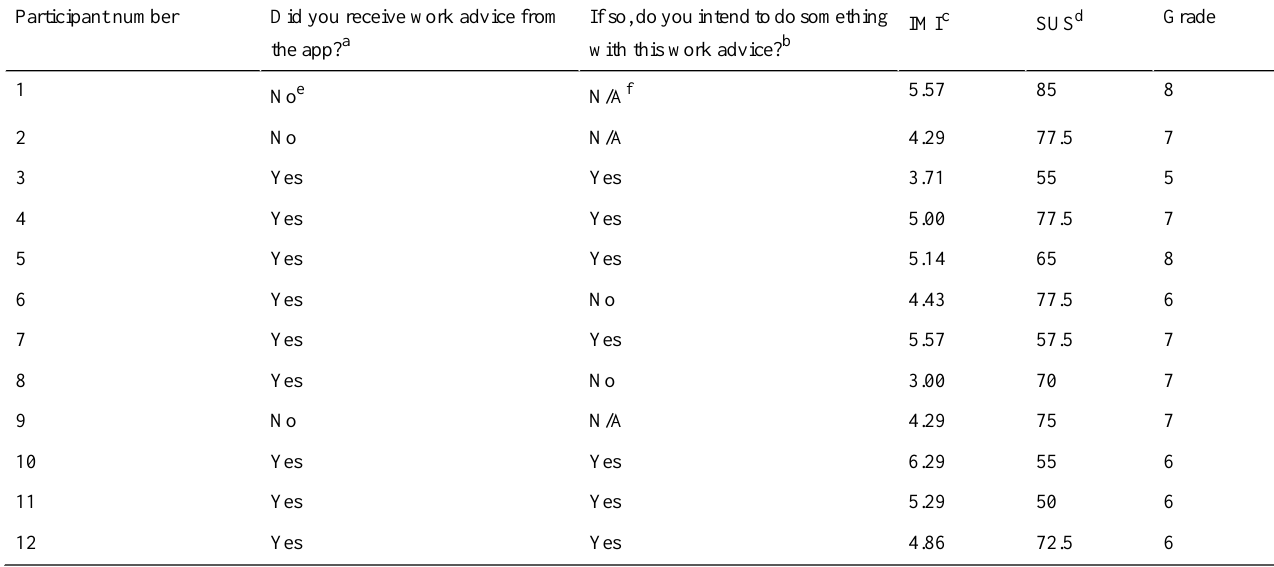
Table 4. User evaluation based on the use of work advice, Intrinsic Motivation Inventory (IMI), System Usability Scale (SUS), and grade.